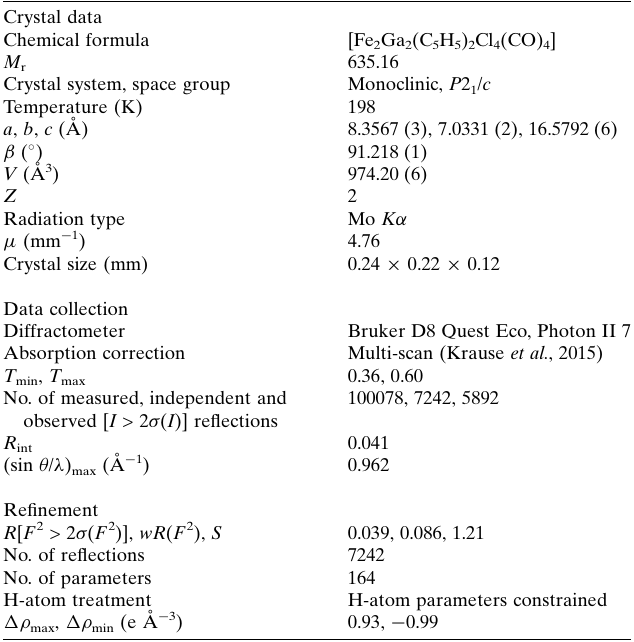
Table 1 Experimental details.